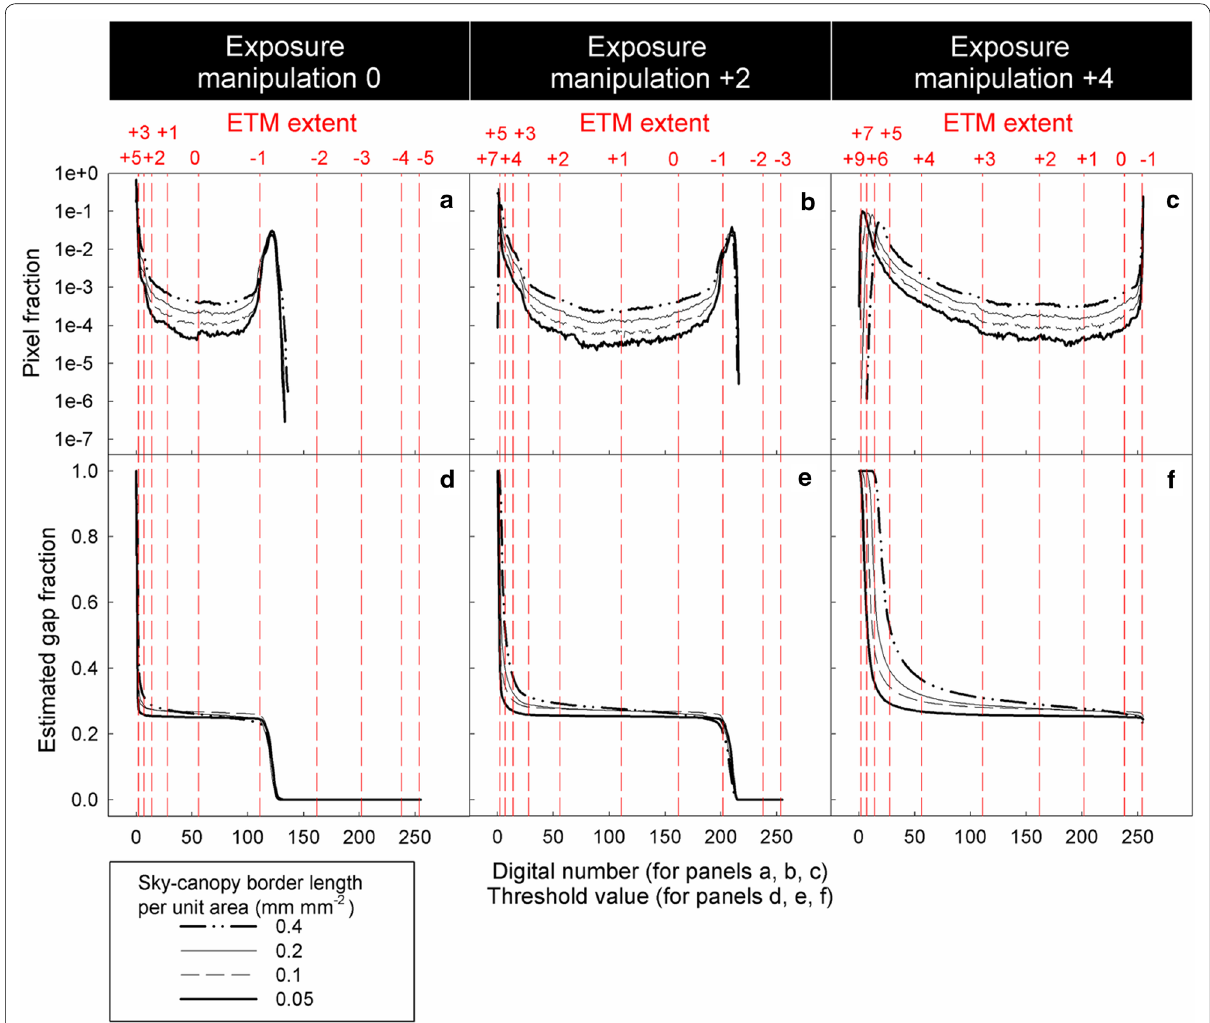
Fig. 7 a – c Frequency distribution of pixel fraction along the greyness gradient of model CHPs, and d – f estimated gap fraction under different ETM extents. In a – c , grey pixels are those in between the humps of canopy and sky pixels. The figure is derived from CHPs of four model canopies with the same designed gap fraction of 0.25 and SCB length per unit area ranging from 0.05 to 0.4 mm mm − 1 . Note log scale used on y‑axis of